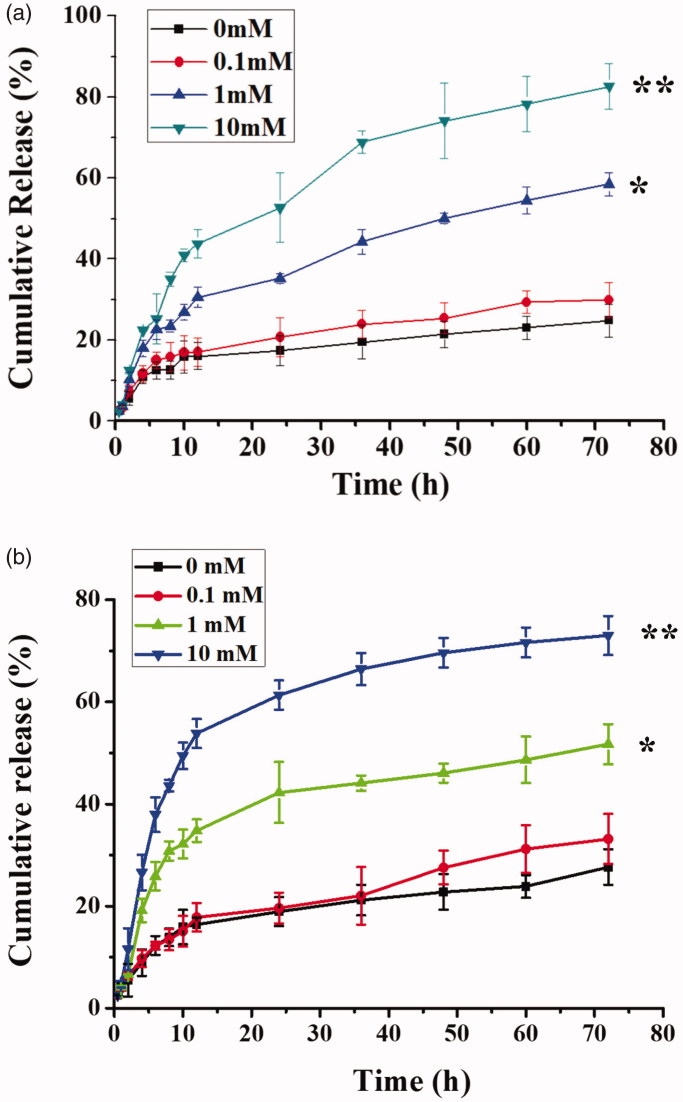
In vitro release profiles of Cur (a) and Bai (b) from the QHMF@Cur/Bai NMs in medium containing 0, 0.1, 1, and 10 mM of GSH.